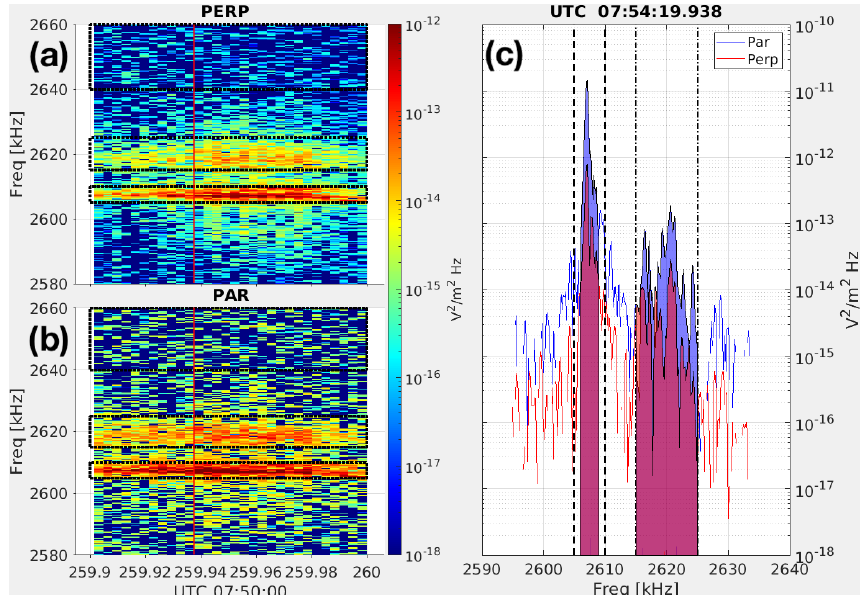
Figure 5. (a) Perpendicular and (b) parallel spectrograms for the Langmuir bursts labeled 260s in Fig. 2 and shown in Fig. 4a. Black boxes indicate the frequency–time ranges used to define the plasma line, diffuse feature, and background level. (c) Selected spectrum with background noise subtracted, occurring at the time highlighted as a red vertical line in panels (a) and (b) , showing the power spectral density of the parallel waves (blue) versus the perpendicular waves (red). Table 1. Mean ratios of E || /E ⊥ , maximum E || /E ⊥ defined as the mean of the three largest ratios for each event, and minimum E || /E ⊥ defined as the mean of the three smallest ratios for each event with their standard deviations for both the plasma line ( f p ) and the diffuse feature ( f diff ), for Langmuir bursts defined in Figs. 2–4. Events 351 and 359 were split into two separate events because of the gap in the plasma line in the middle of the event